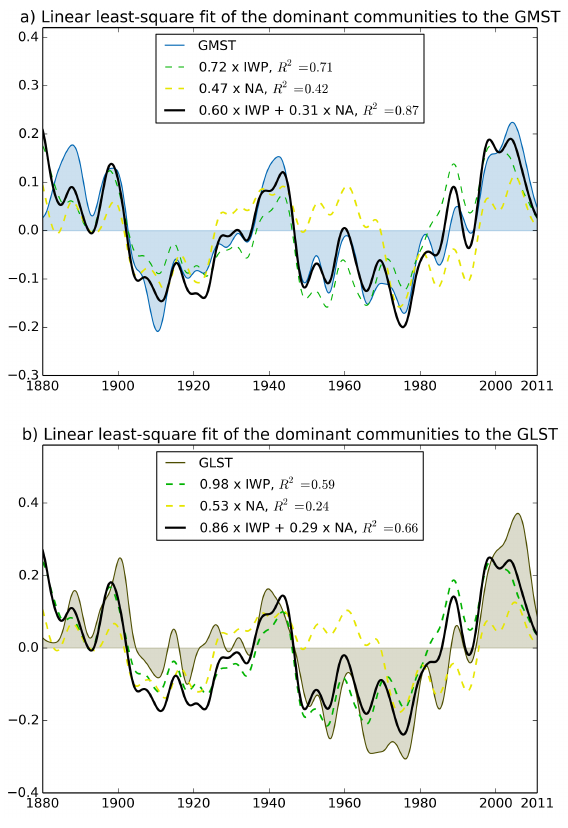
Fig. 7: Regression of the mean time series of the IWP and NA communities of the H-SST-LP8y network to the (a) GMST and (b) GLST.